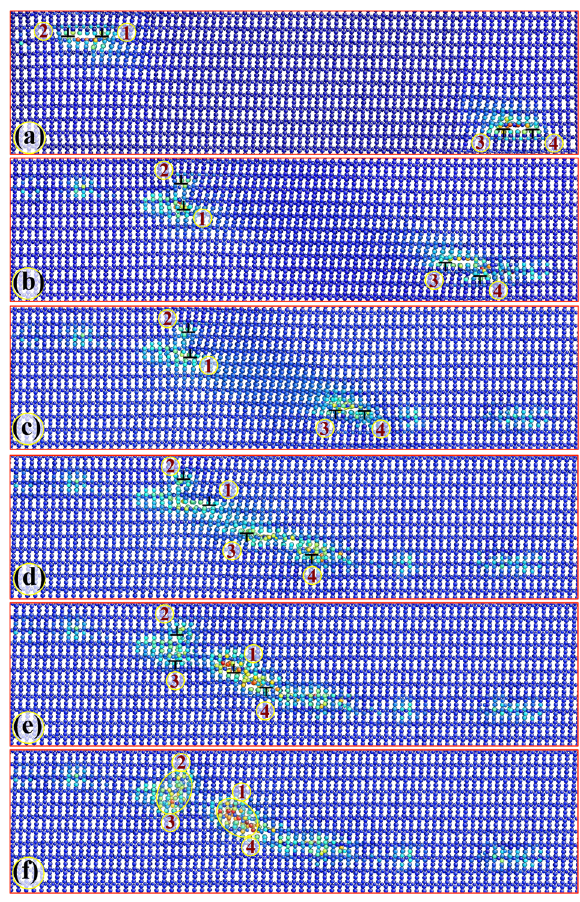
Fig. 3 Interaction of a pair of dislocation dipole with the separation of h = 2.83 nm. At temperature of 700 K, atomic structures asso- ciated with a the glide of four partials, b the climb of partials 1 for eight atomic planes and partial 3 for four atomic planes, c partial 4 climbs for four atomic planes, and glides with partial 3 on the same plane, d partials 1 and 3 attract each other, quickly move towards each other, e partials 2 and 3 are vertically positioned, forming vacancy cluster, and f partials 1 and 4 are vertically positioned, forming vacancy cluster. The symbol “ ⊥ ” indicates the position of planes and the stacking fault associated with the glide of partial 1 is extended. After 176 ps, partial 2 climbs for four atomic planes and glides on the same shear plane with partial 1 as a full dislocation together (Fig. 2e). As a result, dislocations annihilation did not occur (also see Movie II in Supplementary Information). Figure 2f shows the position and velocity of dislocations with simulation time. The fi rst climb occurs at t = 92 ps, the correspond- ing separation L is 3.04 nm, and the shear stress is 2.0 GPa. The two sets of dislocations glide at velocities of 505 m/s for the dislocations 1 and 2 and 380 m/s for the dislocations 3 and 4, being far lower than the shear wave speed of Al 2 Cu. After partial 3 climbs for eight atomic planes, dislocations 3 and 4 are pinned by the vertical-extended core and vacancies. Partials 1 and 2 continuously glide after partial 2 climbs on the same shear plane as partial 1 is.